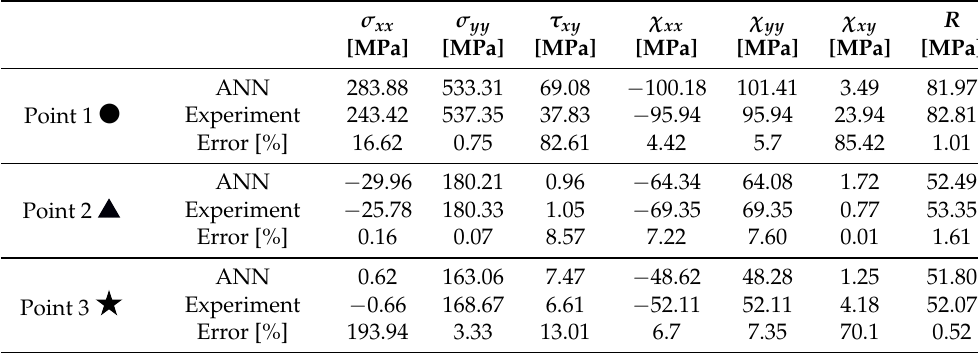
Table 7. Comparison between the ANN model and the (virtual) experimental values at the end of the butterfly test for selected points: stress comparison [22].